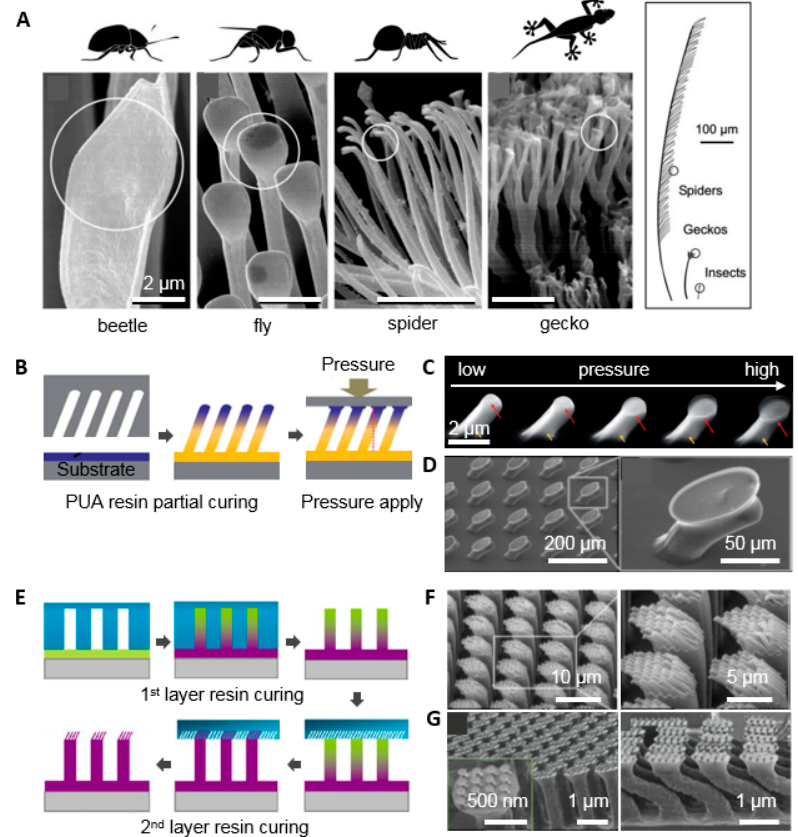
Figure 4. ( A ) Various tip and hierarchical structures for attachment in nature (reproduced from